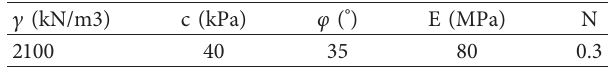
Table 5: Parameters of the soil after